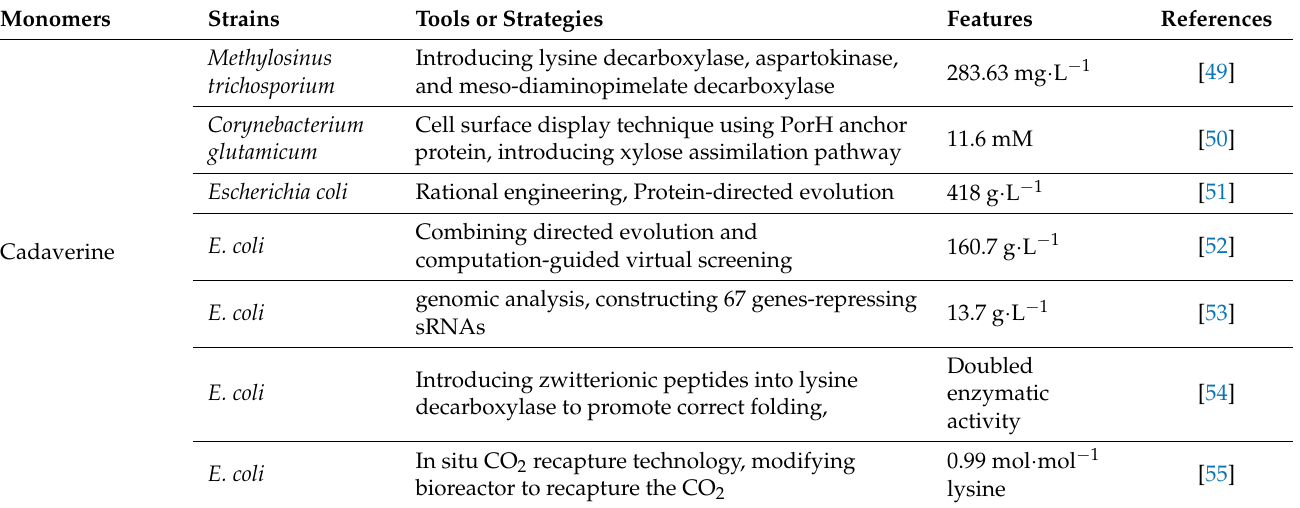
Table 2. Metabolic engineering strategies on microorganisms for monomer